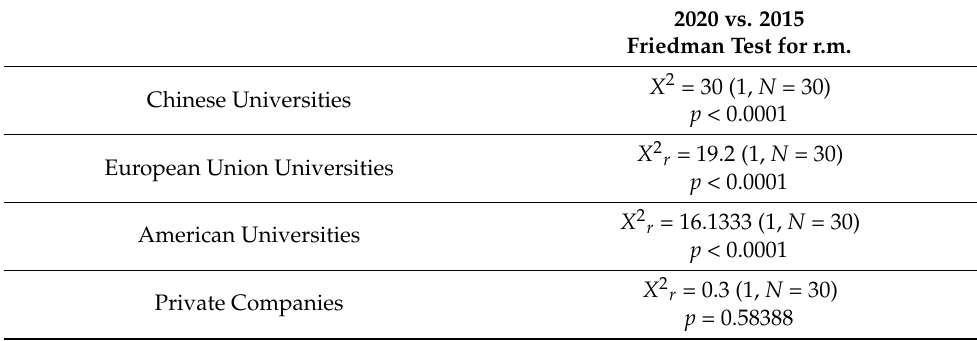
Table 8. Trends within groups over time in sub-indicator “Sociality” in the best 30 universities of China, the European Union, the US, and in private companies Friedman test for repeated